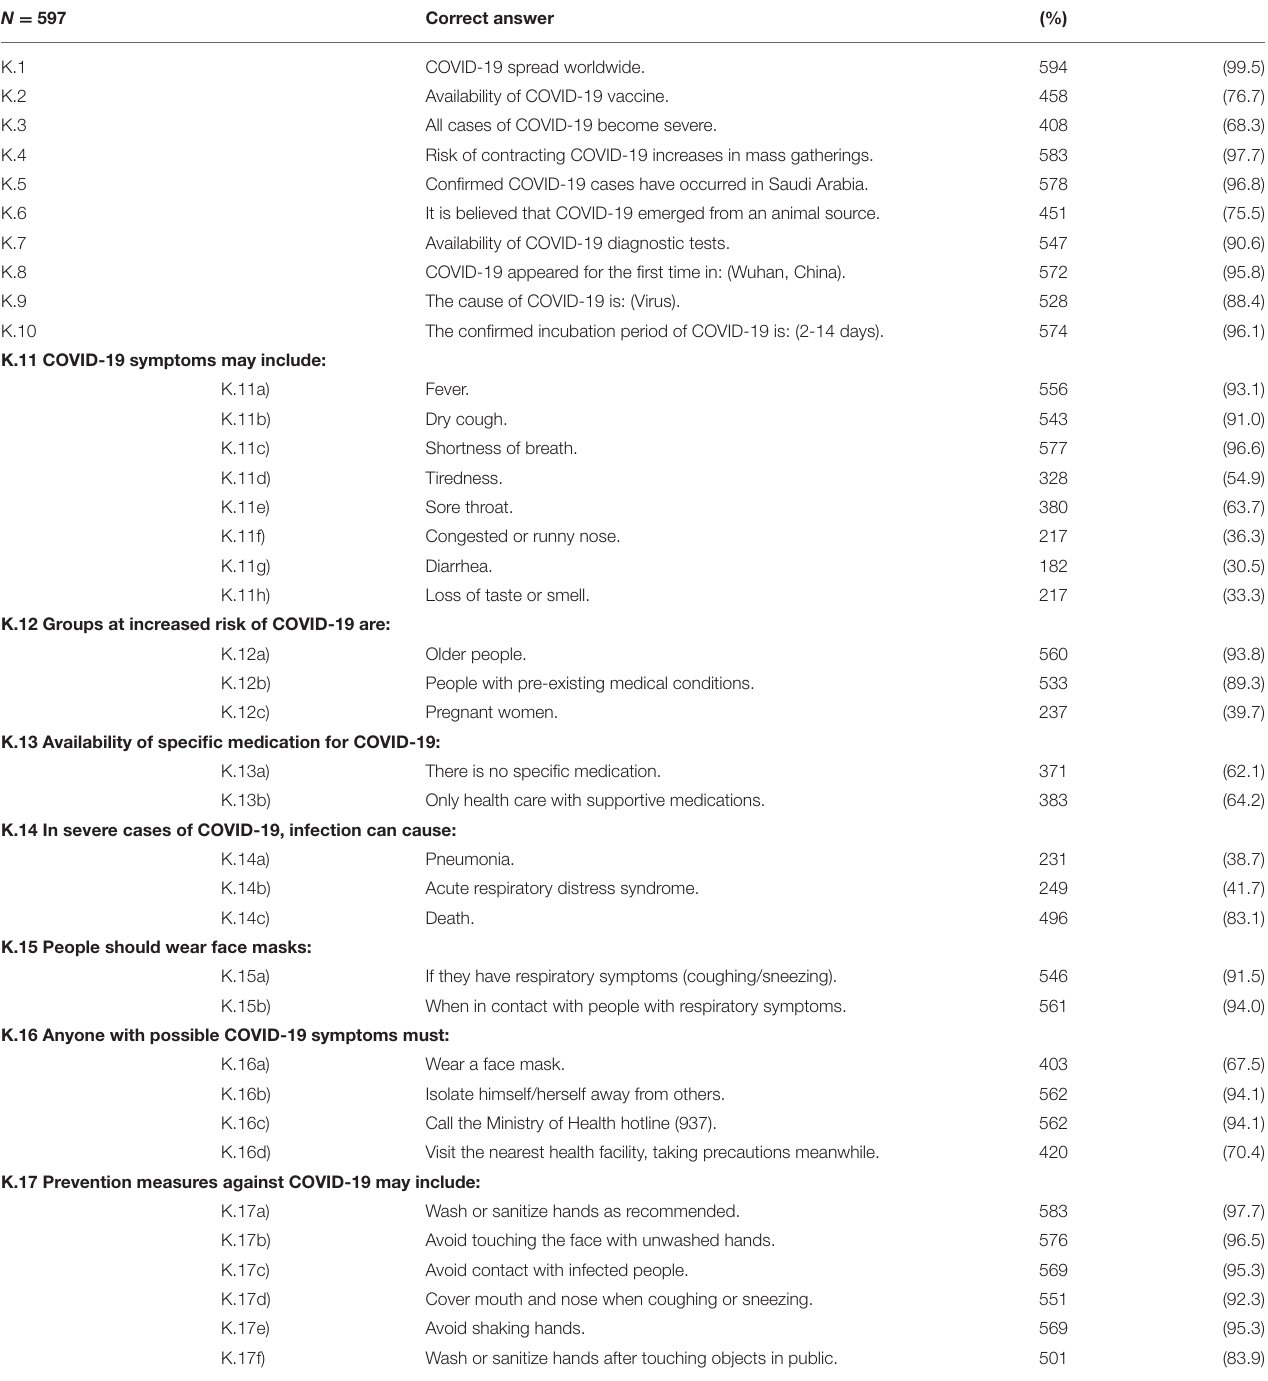
TABLE 2 | Responses to questions about COVID-19